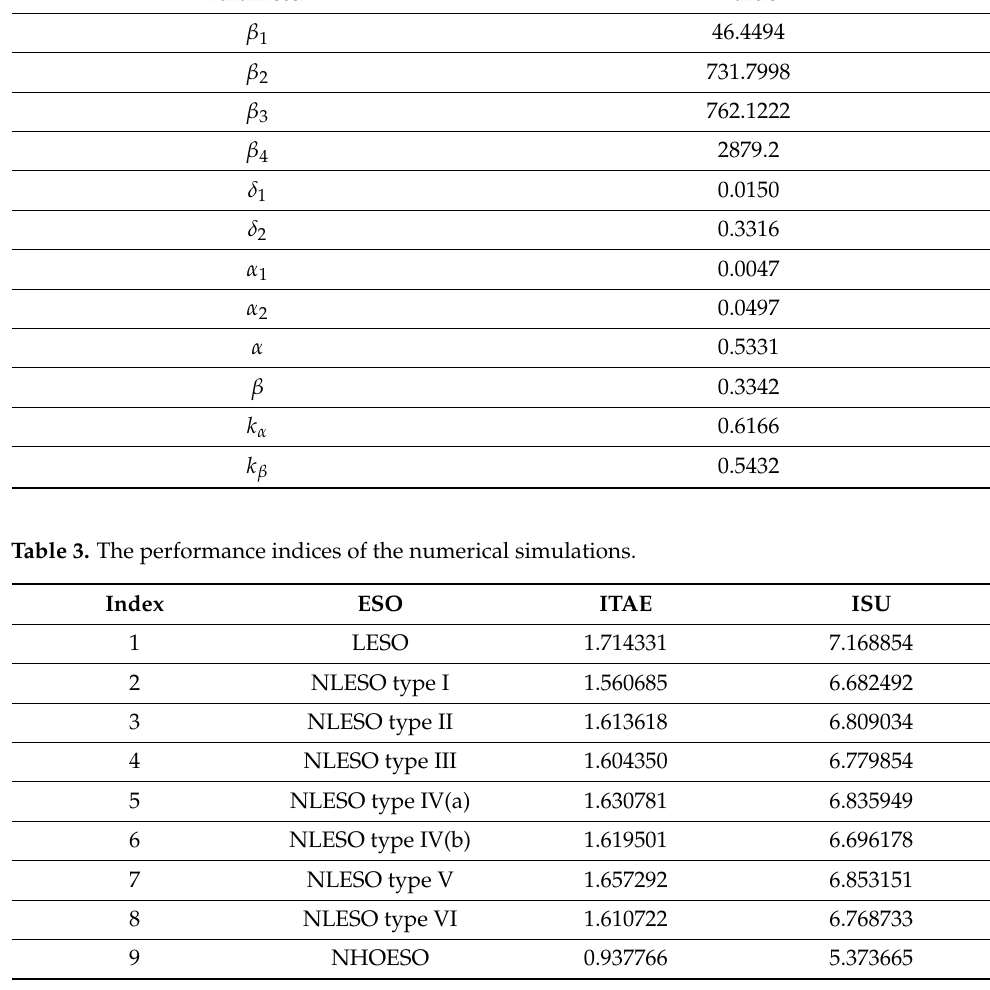
Figure 4. The estimation errors with curve indices from 1 to 9 represent LESO, NLESO types I, II, III, IV(a), IV(b), V, and VI, and NHOESO, respectively.